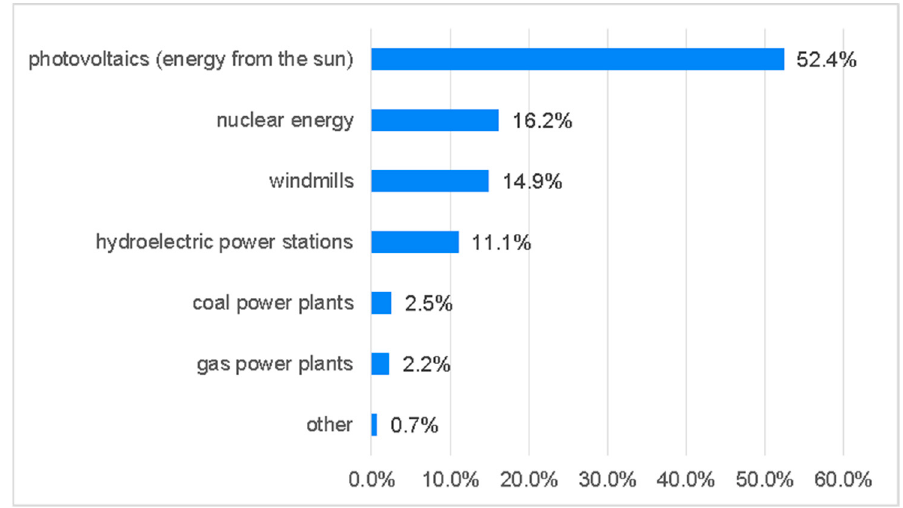
Figure 9. Respondents’ expectations regarding the development of energy sources in Poland.